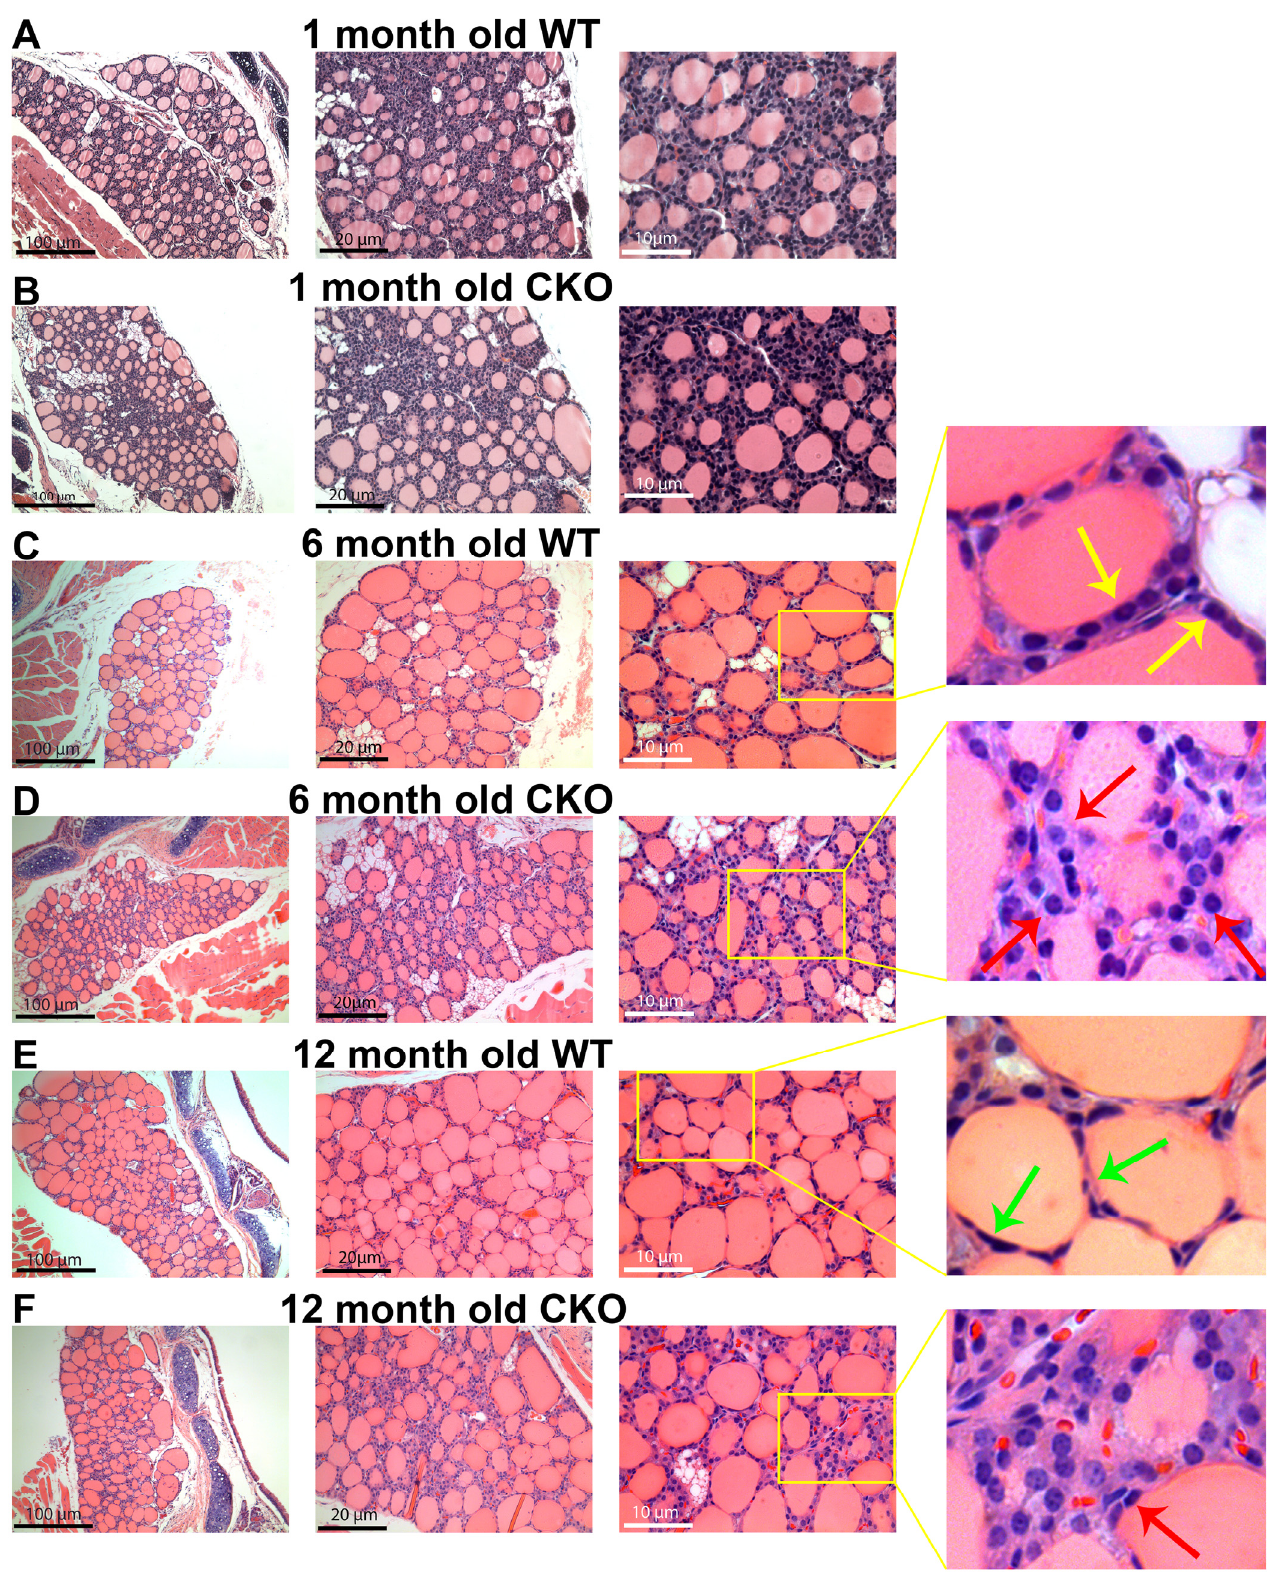
Figure 3. Hematoxylin and eosin (H&E) -stained thyroid gland sections from CKO and W.T. male mice. ( A , B ) 1-month-old W.T. and CKO mice showed no difference in the histology of the thyroid gland. ( C ) At 6 months old, W.T. mice had small follicles in the central zone and intermediate-to-large-sized follicles in the peripheral zone. Furthermore, the thyrocytes exhibited a columnar-to-